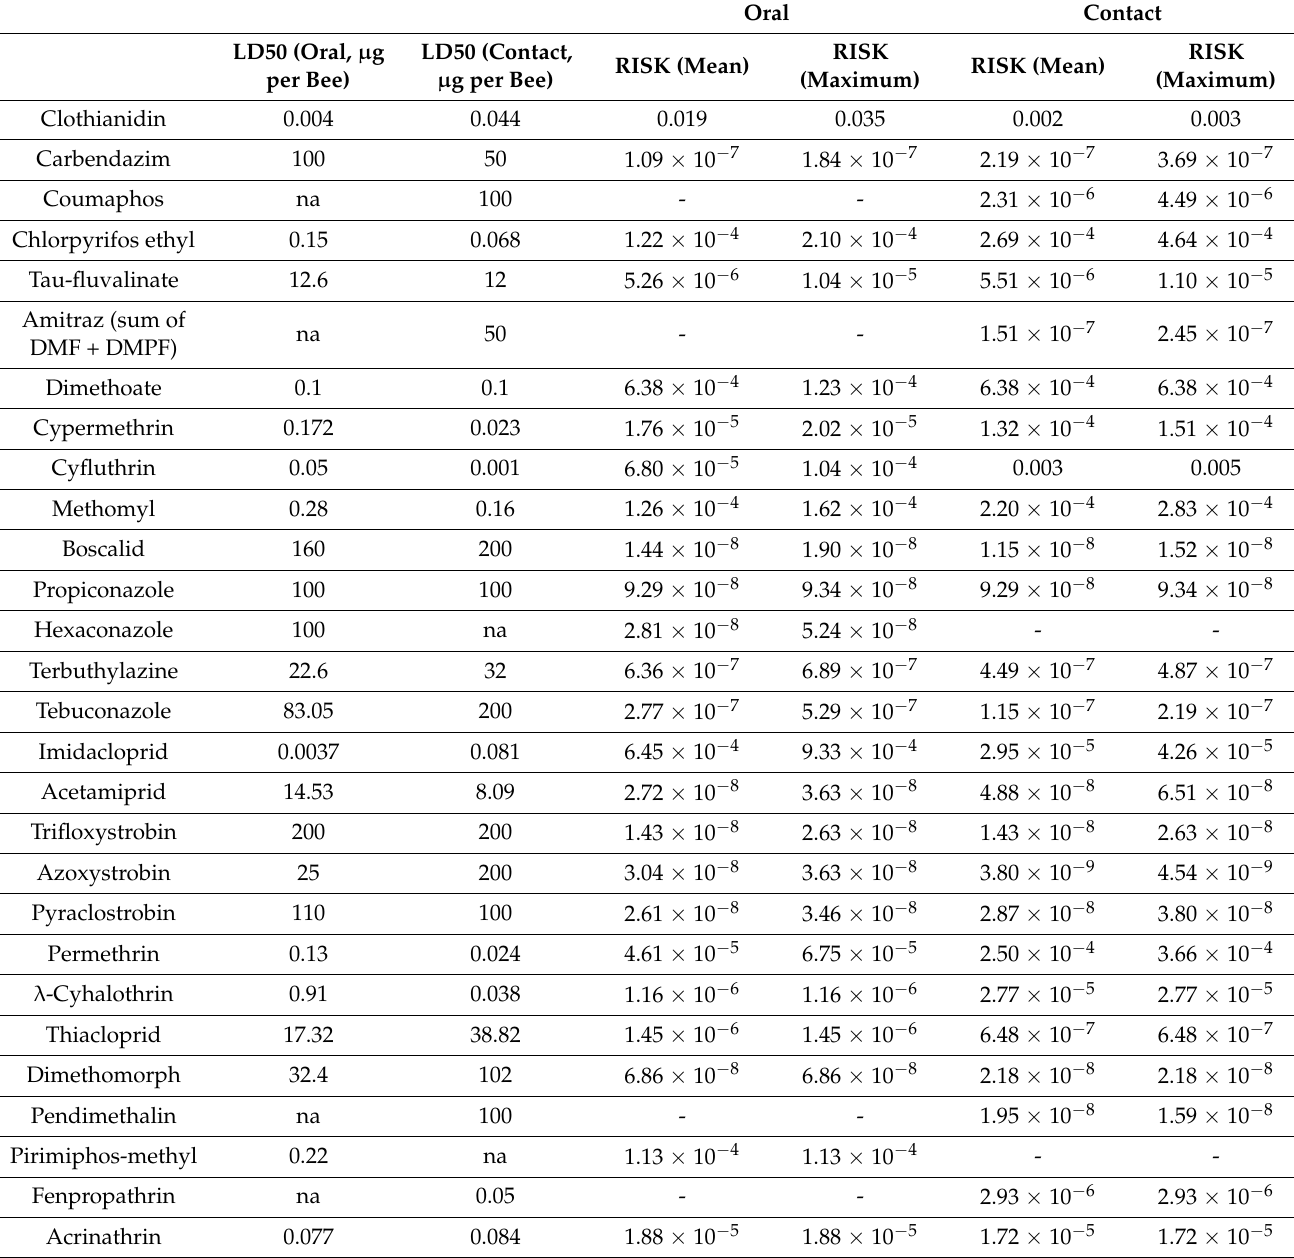
Table 4. Risk calculations for honeybees based on the active substances (mean and maximum concentrations) quantified in pollen